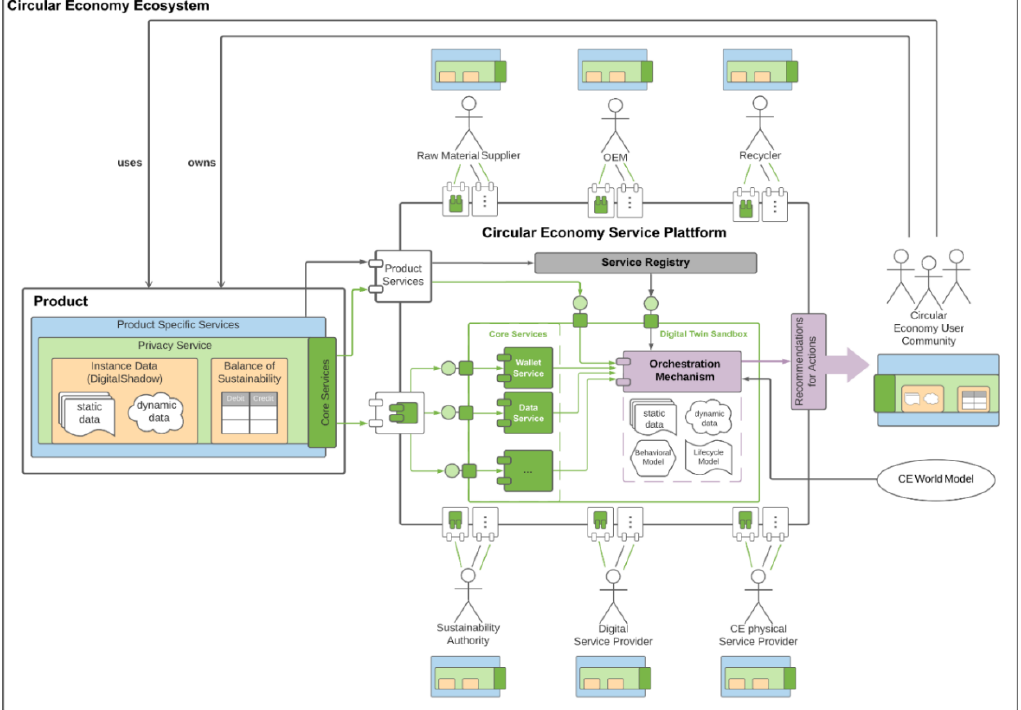
Figure 4. Architectural blueprint for a Circular Economy ecosystem.